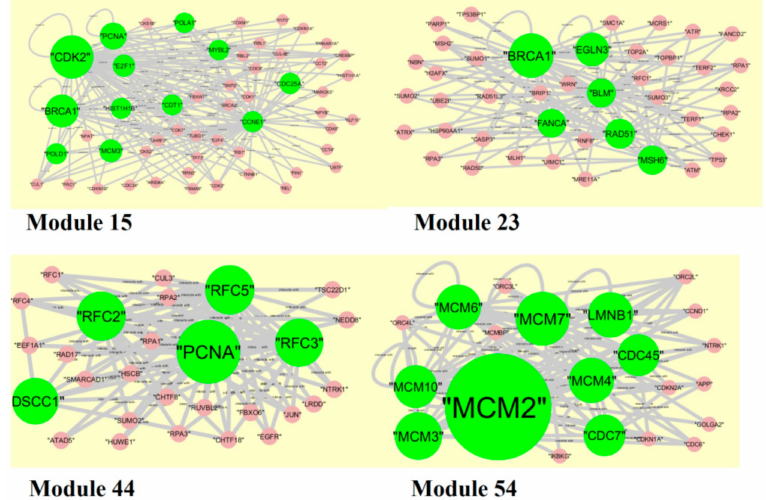
Figure 11. Modules in protein-protein interaction (PPI) network. The green nodes denote the up-regulated genes.